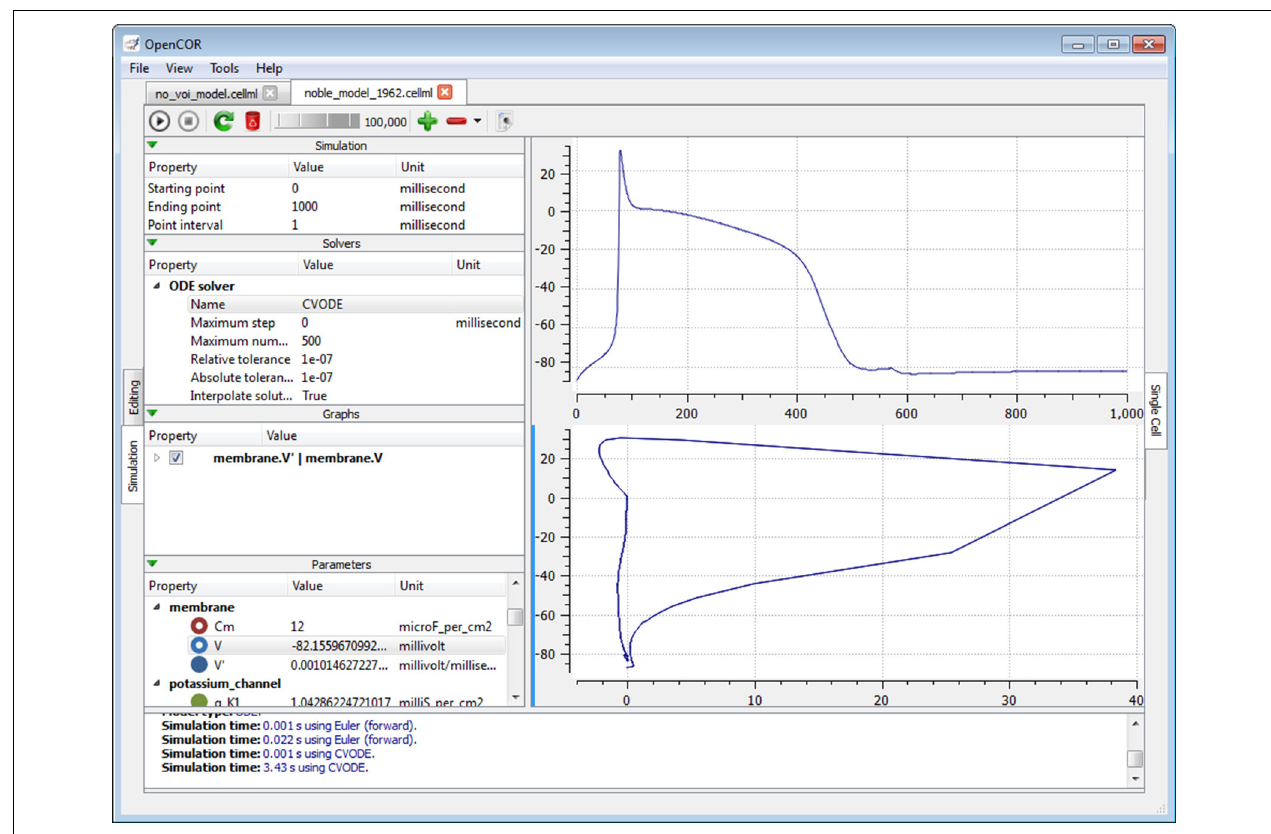
FIGURE 7 | Single Cell view. The Single Cell view can be used to run CellML files that describe a system of differential equations, be they ordinary or algebraic. Different solvers can be used and any model parameter can be plotted against any